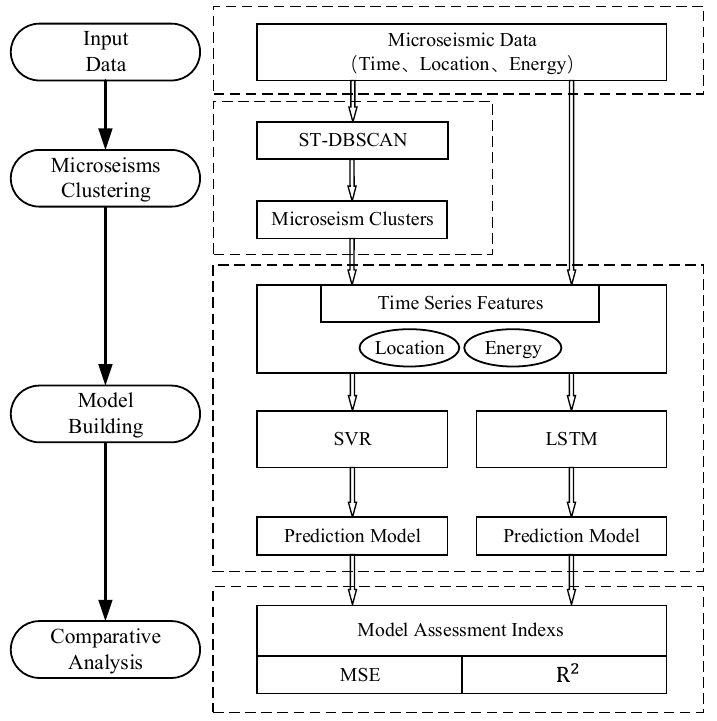
Figure 5. The workflow of mine earthquake prediction in time